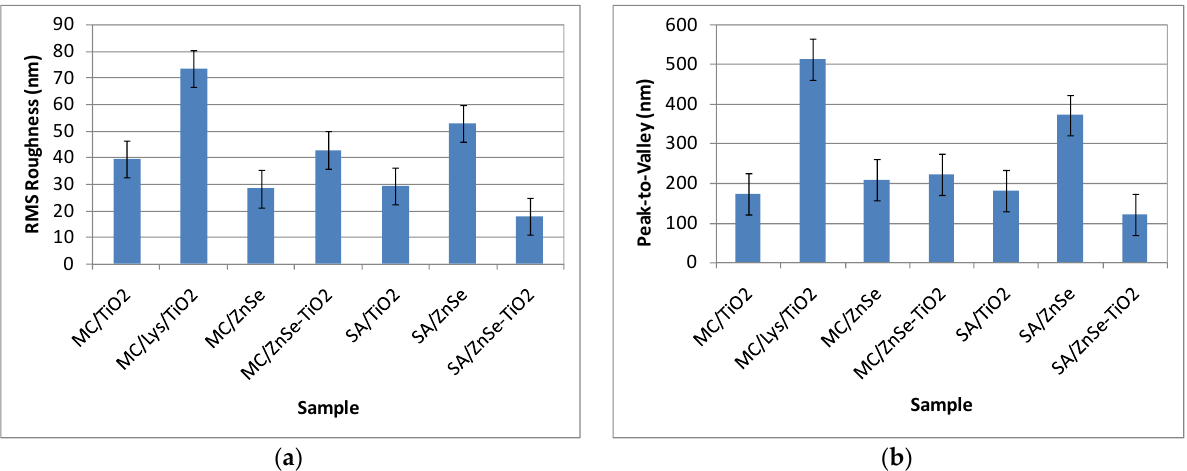
Figure 15. Corrugation characteristics of all scanned systems: RMS roughness ( a ) and peak-to-valley ( b ) from inoculum, evaluated from AFM images measured after 1 h.